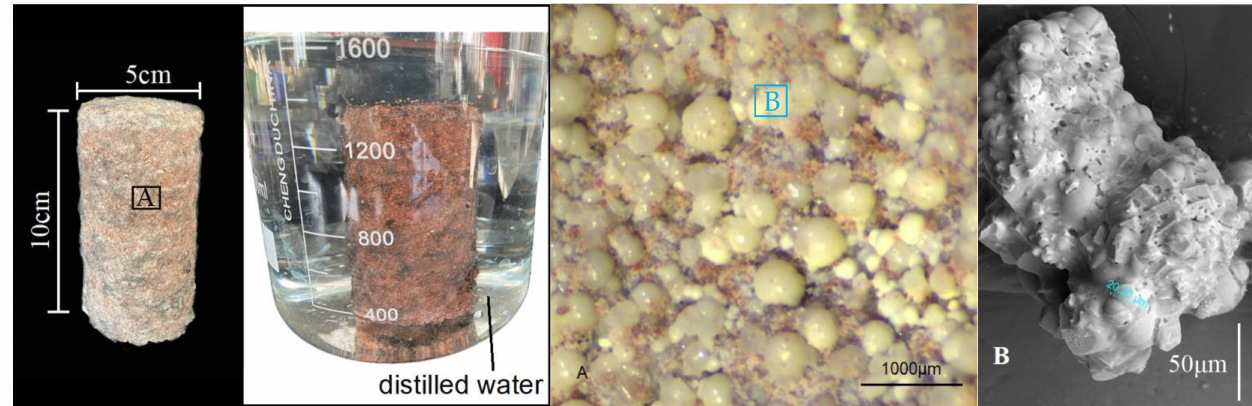
Figure 8. Improved soil samples of Pisha sandstone weathered soil before and after immersion. (A and B are the location of SEM test points